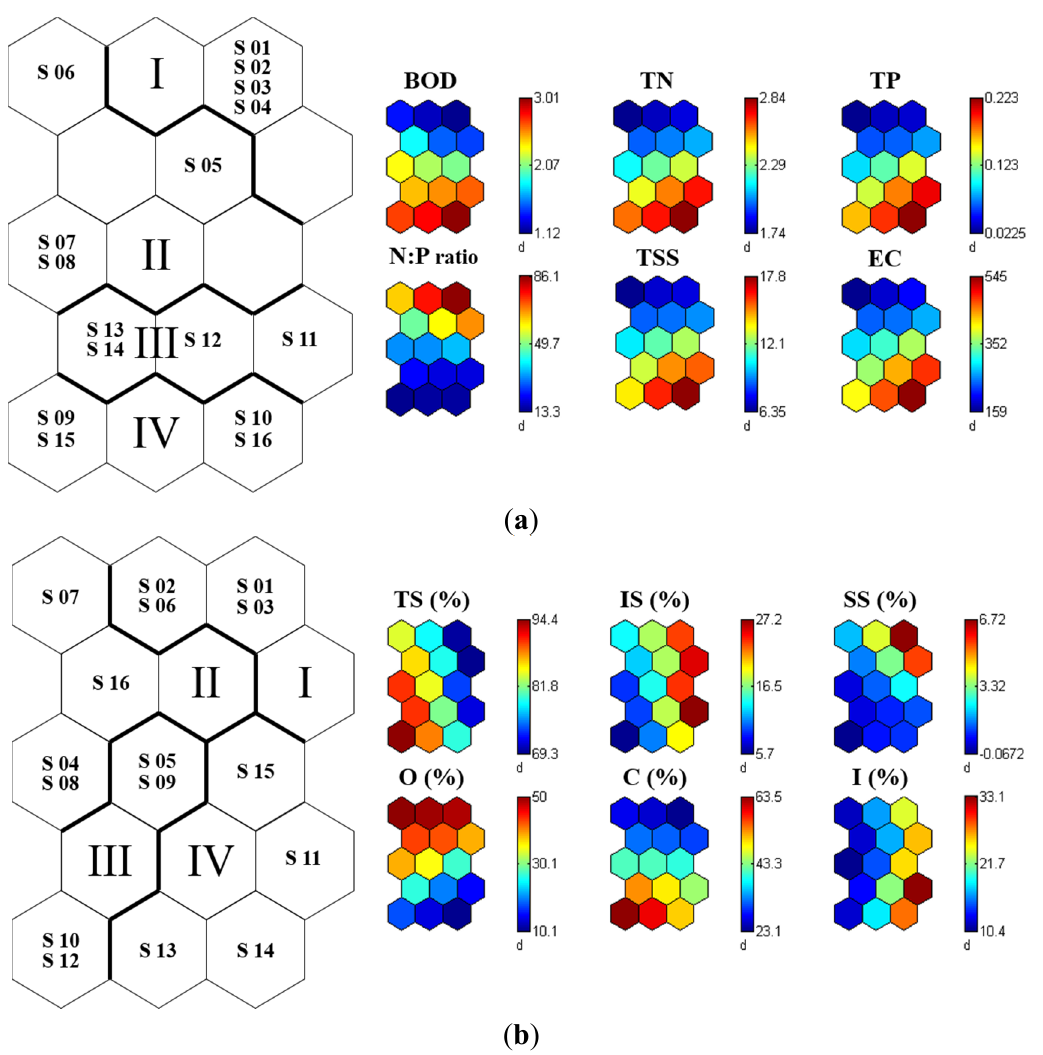
Figure 2. Clustering of the trained self-organizing maps (SOMs) units for chemical parameters and biological parameters. The four groups (I–IV) indicate different clusters of ecological characteristics, and the code in each unit of the map refers to the sampling site. The mean value of each variable was calculated from each output neuron of the trained SOM. The red and blue colors indicate a high and low value, respectively, for each environmental parameter: ( a ) Chemical parameters and ( b ) biological